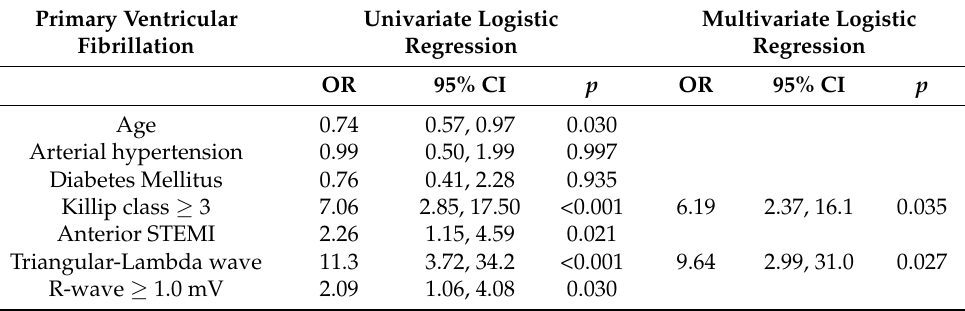
Table 3. Predictors of primary ventricular fibrillation at logistic regression